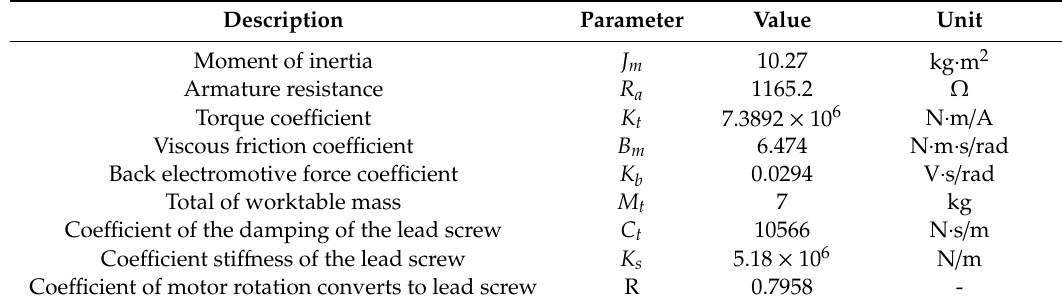
Table 1. Parameters of the feed-driven system model, as well as their descriptions and